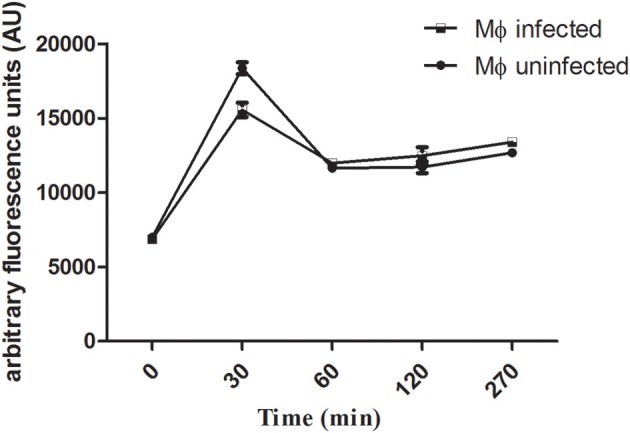
Uptake of liposomal sertraline labeled with rhodamine 123 by Leishmania-infected and uninfected macrophages. The uptake was measured by the fluorescence intensity within macrophages using a flow cytometry (Attune-Thermofisher) for a period of 270 min. A number of 10,000 events were analyzed for each time.